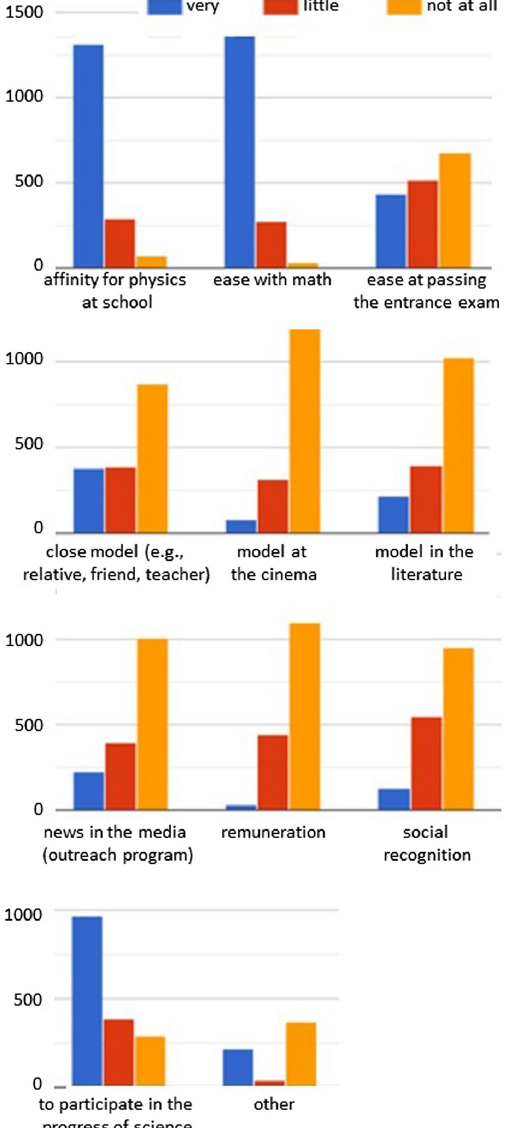
FIG. 4. Motivations for choosing physics. Histograms showing the number of (nonexclusive) responses associated with each possible motivation given in a list, according to the level of identification (very, little, not at all). Horizontal lines are drawn